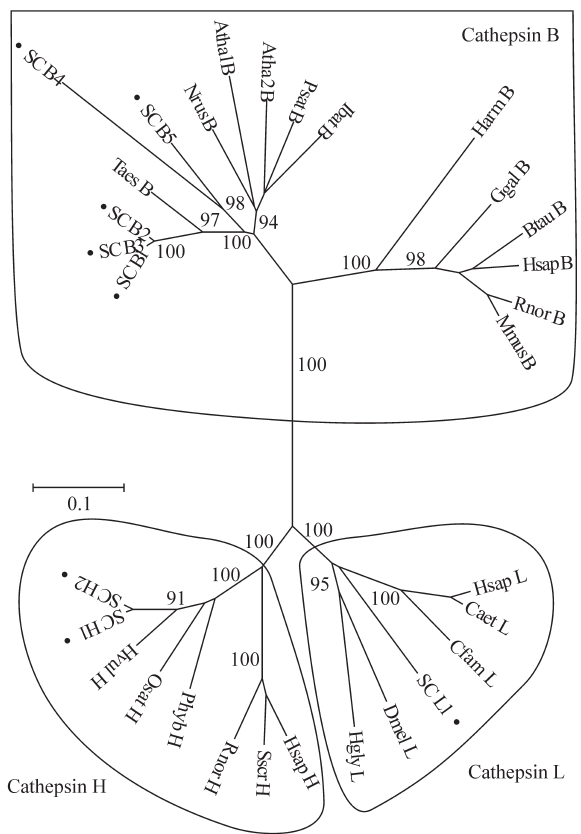
Figure 2 - Phylogenetic unrooted tree of cathepsins B, H and L. The tree was constructed using Neighbor-joining and pair-wise deletion parame- ters, with an internal branch test with 5000 replications. The analysis was performed based on the MAP alignment of eight Sugarcane clusters, 12 cathepsin-B, six cathepsins-H and five cathepsin-L. The three major clus- ters,correspondingtoeachcathepsinclass,aredemarked.Blackdotsiden-